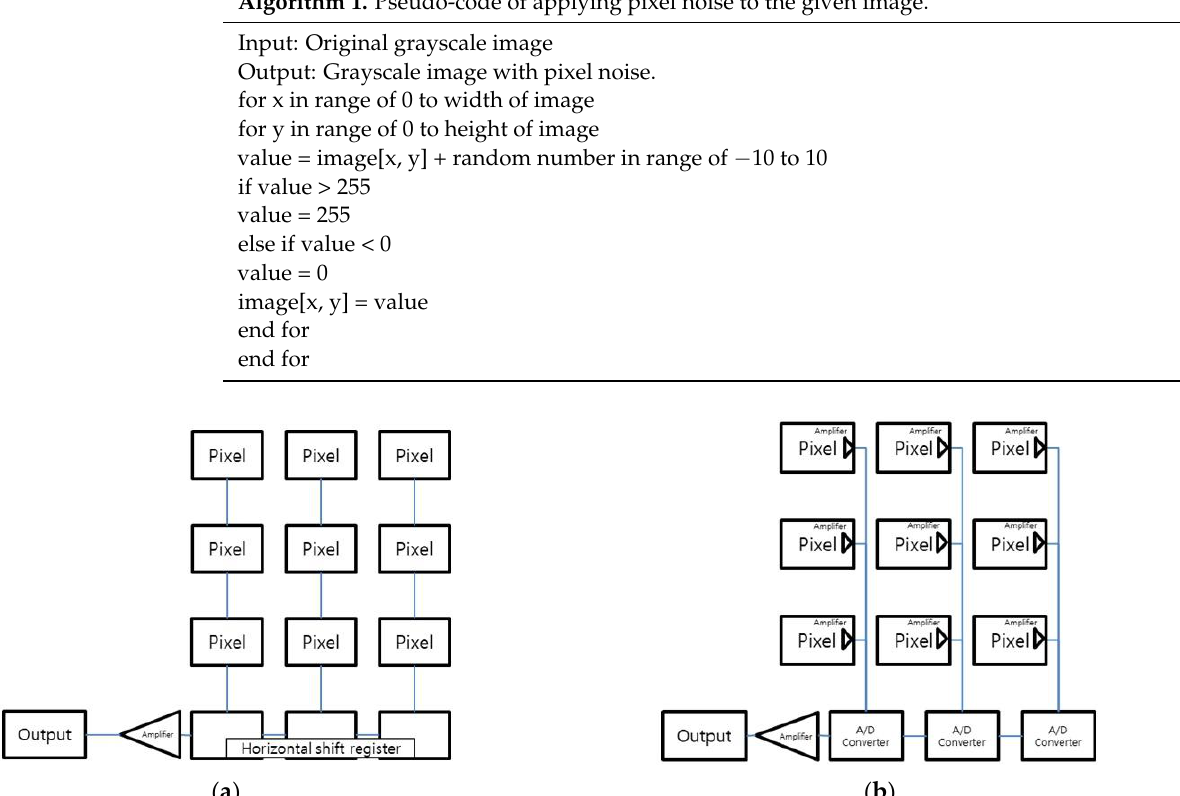
Algorithm 1 Pseudo-code of applying pixel noise to the given image